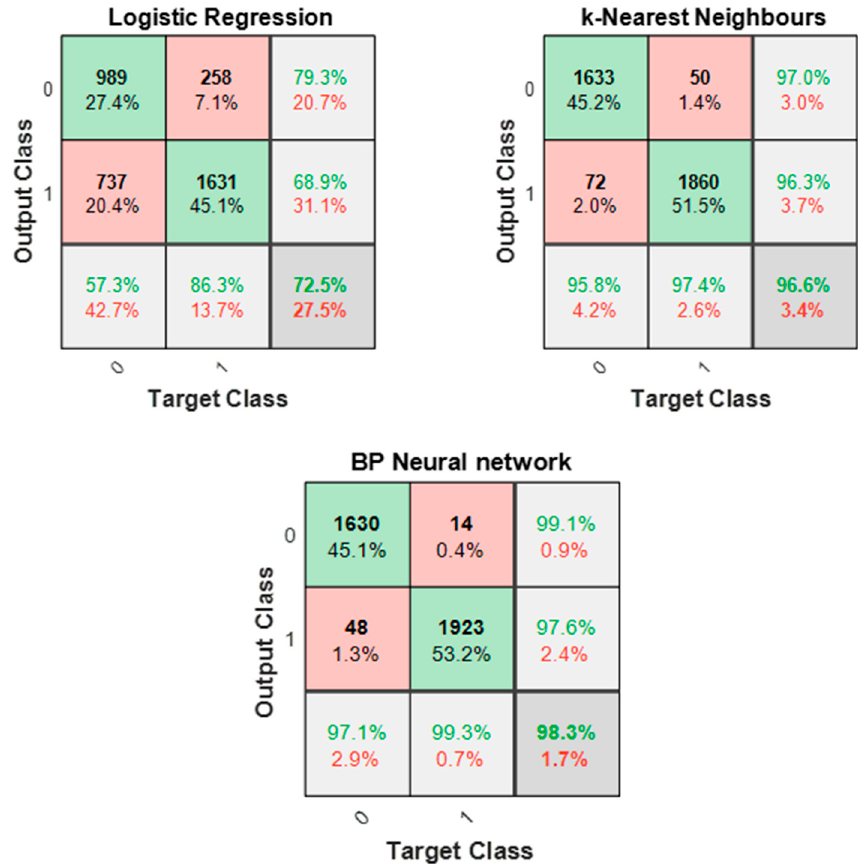
Figure 12. Confusion matrix for all three classifiers.